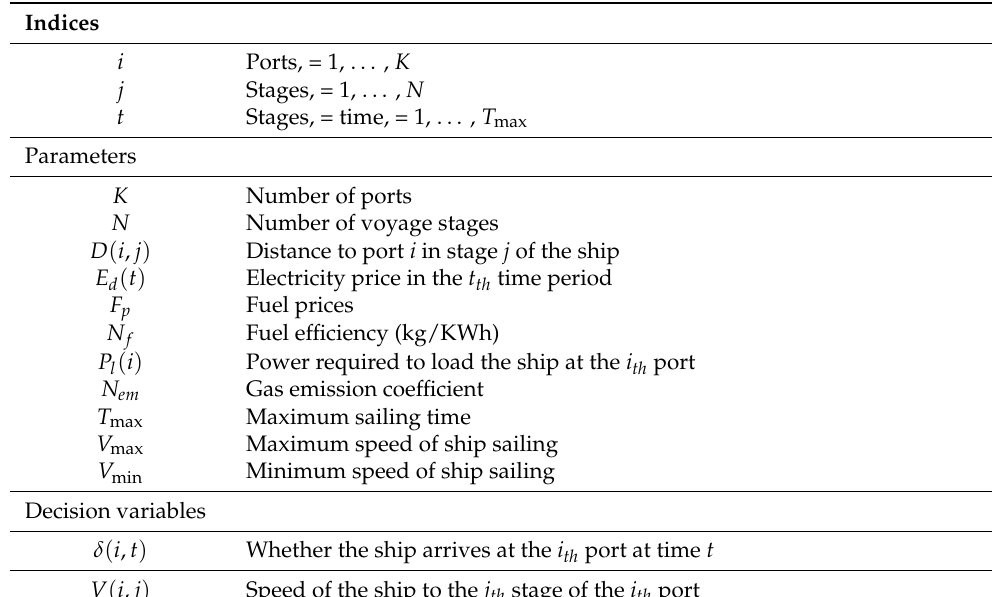
Table 1. Voyage-related variables and